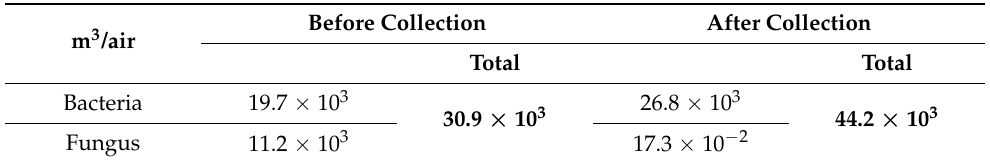
Table 3. Microbiological load in the air collection room before and after the procedure for collecting sperm from